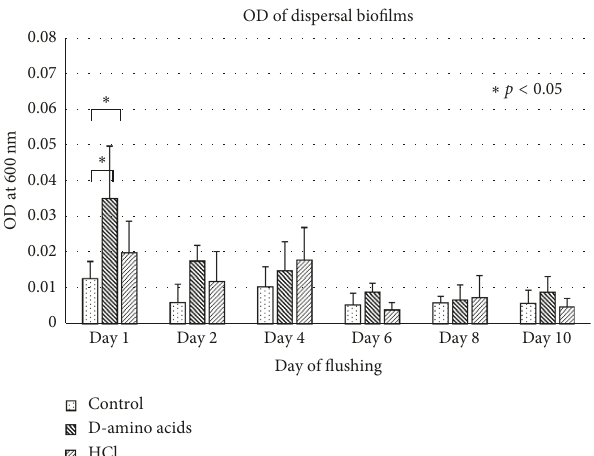
Figure 4: Optical density at 600nm of dispersed biofilms in flushing water collected after the DUWLs of DCUs were incubated with distilled water (control), D-amino acids mixture (D-amino acids, 10mM each), or 0.1M HCl for 5 days. The DUWLs were flushed every other day for 10 days, and the flushing water was collected to measure the OD 600 of dispersed biofilms. ∗ Statistically different at p < 0 .